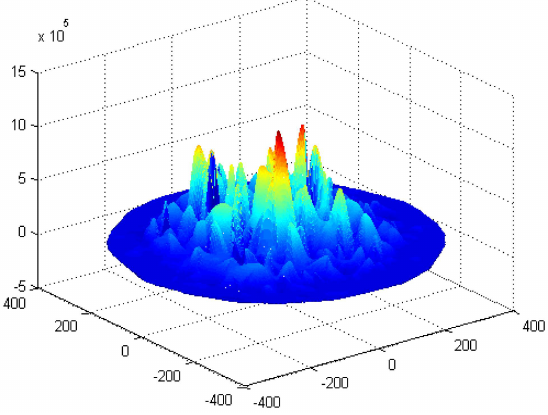
Figure 8. The energy consumption in the PHACK scheme.